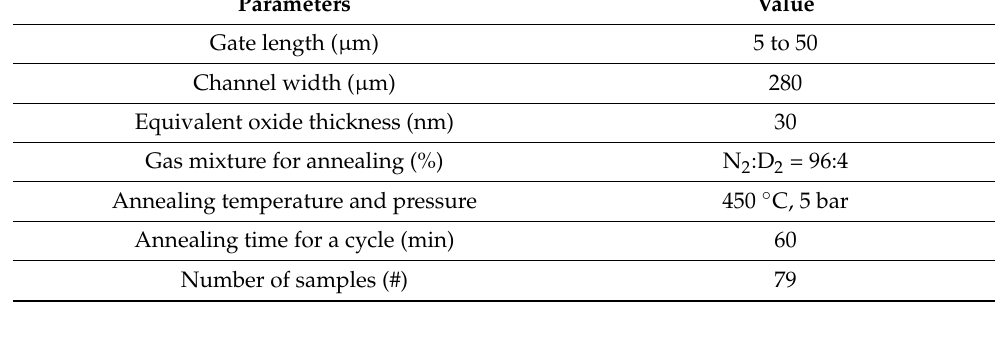
Table 1. Summary of device sizes and annealing conditions.